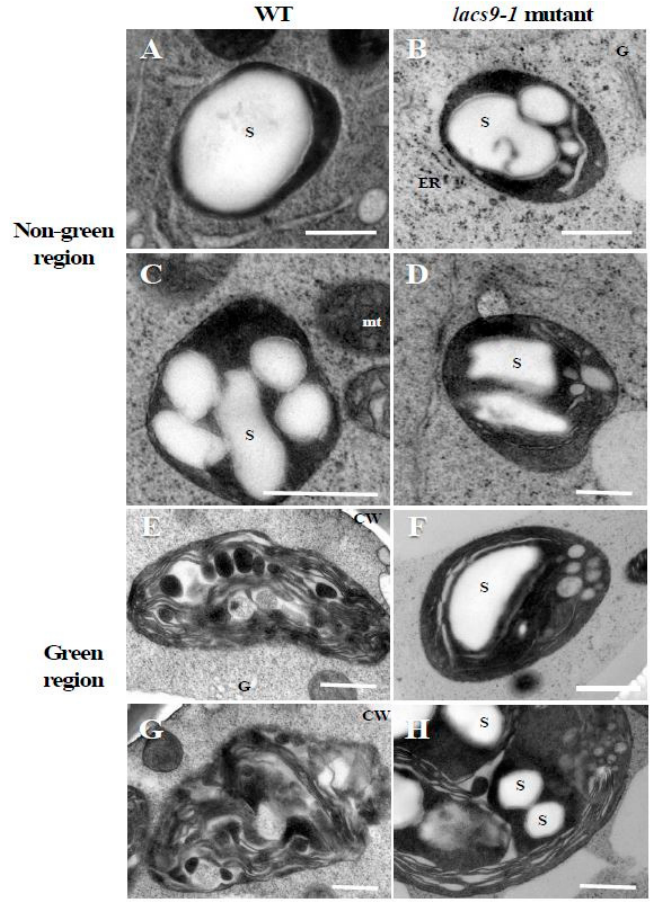
Figure 2. Transmission electron microscope analysis in WT and lacs9-1 mutant cells of rice. Panels ( A , C , E , G ) represent WT, and ( B , D , F , H ) represent lacs9 mutant cultured rice cells. ( A – D ) Nongreen region, ( E – H ) green region. S: Starch granule; CW: Cell wall; ER: Endoplasmic reticulum; G: Golgi apparatus; mt: Mitochondria. Bars = 0.5 µ